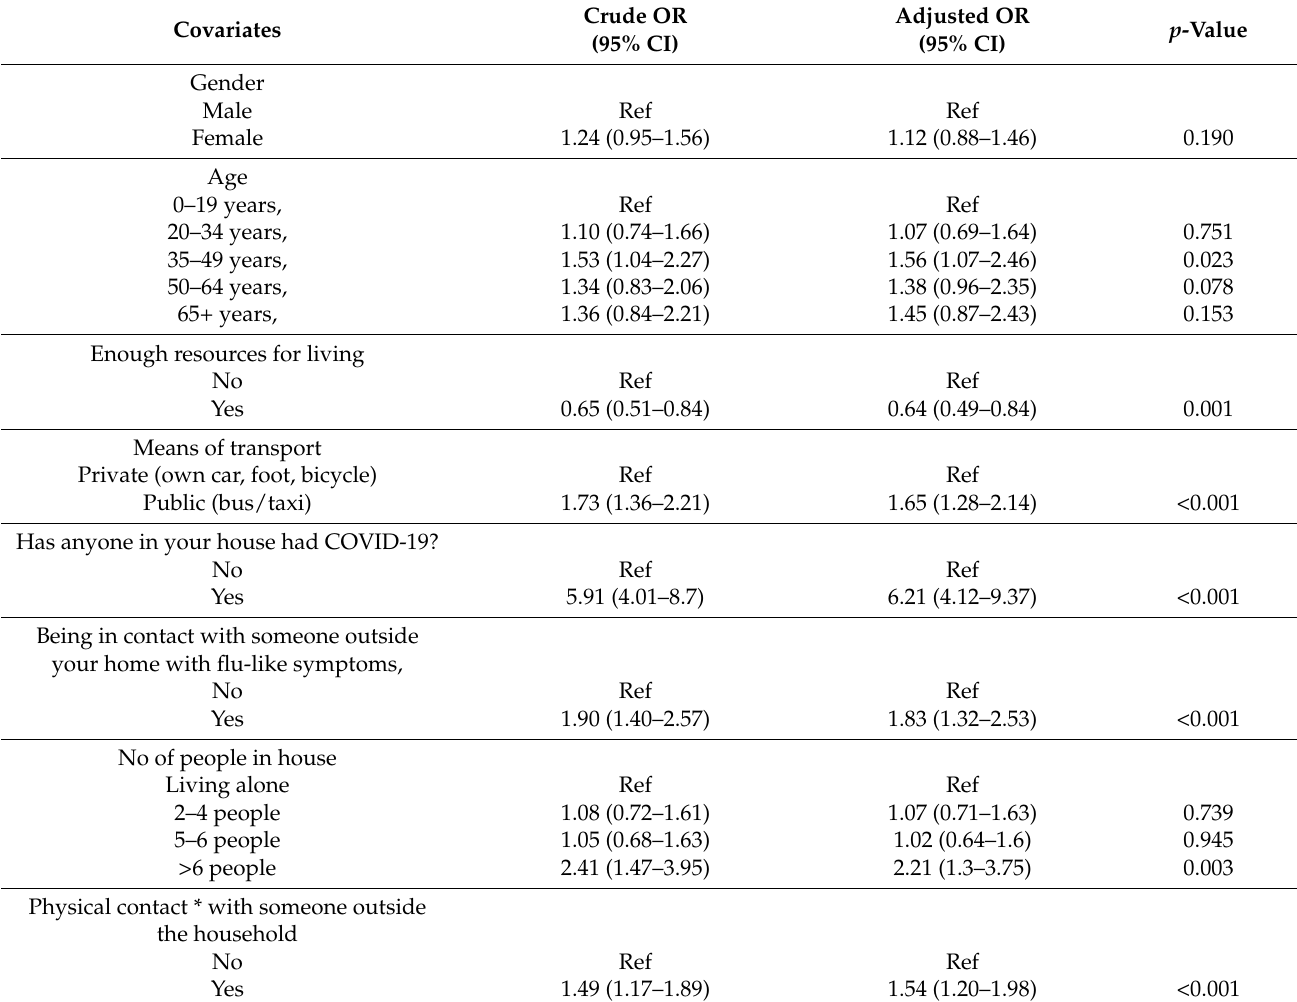
Table 3. Risk factors associated with COVID-19 IgM/IgG